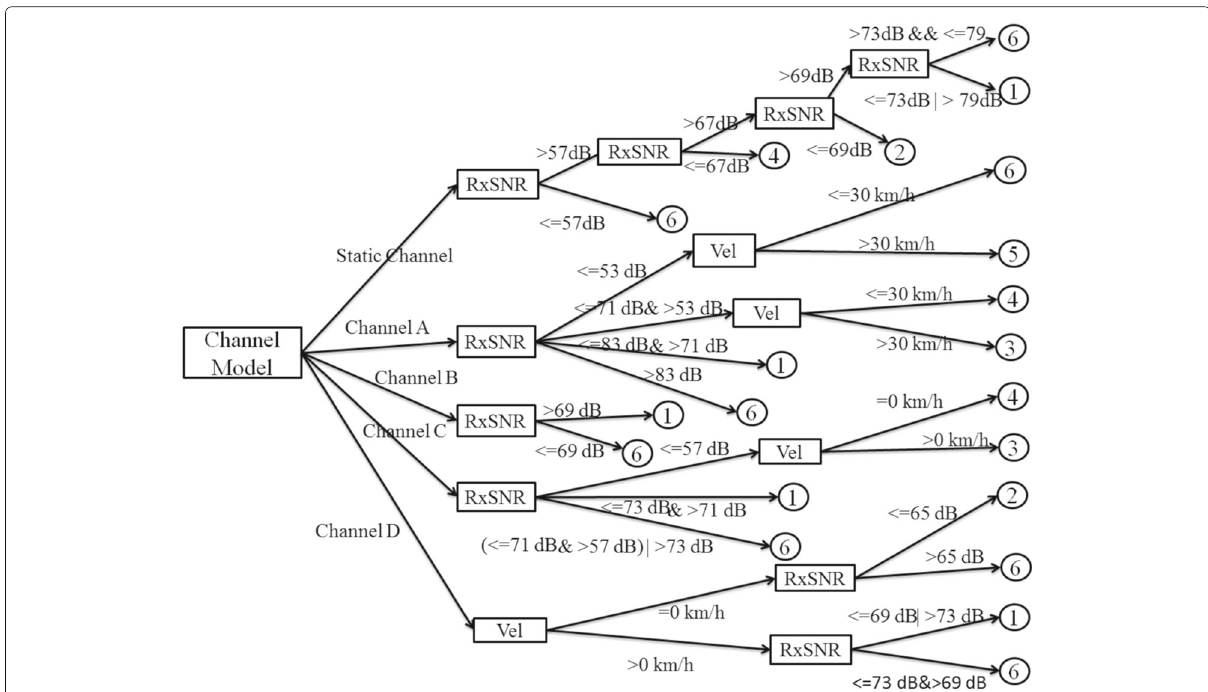
Fig. 2 Decision tree for WARP Measurements. A decision-tree classifier is trained for rate adaptation based on WARP